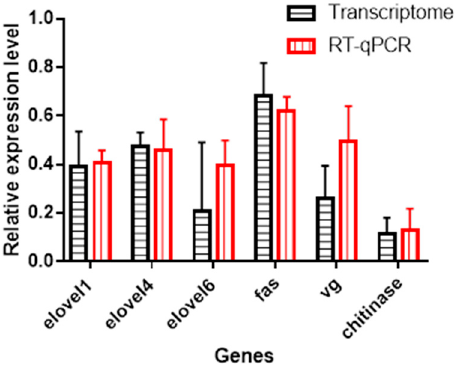
Figure 7. qRT-PCR validation of the partial differentially expressed unigenes (DEGs) in honeybee larvae. qRT-PCR: Relative expression of six selected genes by qRT-PCR (Red column). Transcriptome: Relative expression of six selected genes by transcriptome analysis (Black column); The expression of six genes selected from the KEGG enrichment in the larvae from the EMF group were all downregulated when compared with the expression in the larvae from the CK group by the method of qRT–PCR, which was identical to their corresponding expression level shown in RNA-seq analysis ( t -test, for all the six genes, p > 0.05). This confirmed the accuracy of the RNA-seq results.